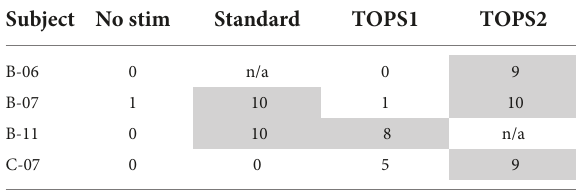
TABLE 4 Strong, sustained side effects were experienced by four subjects during at least one test pattern resulting in stimulation being turned OFF before the 30-min test